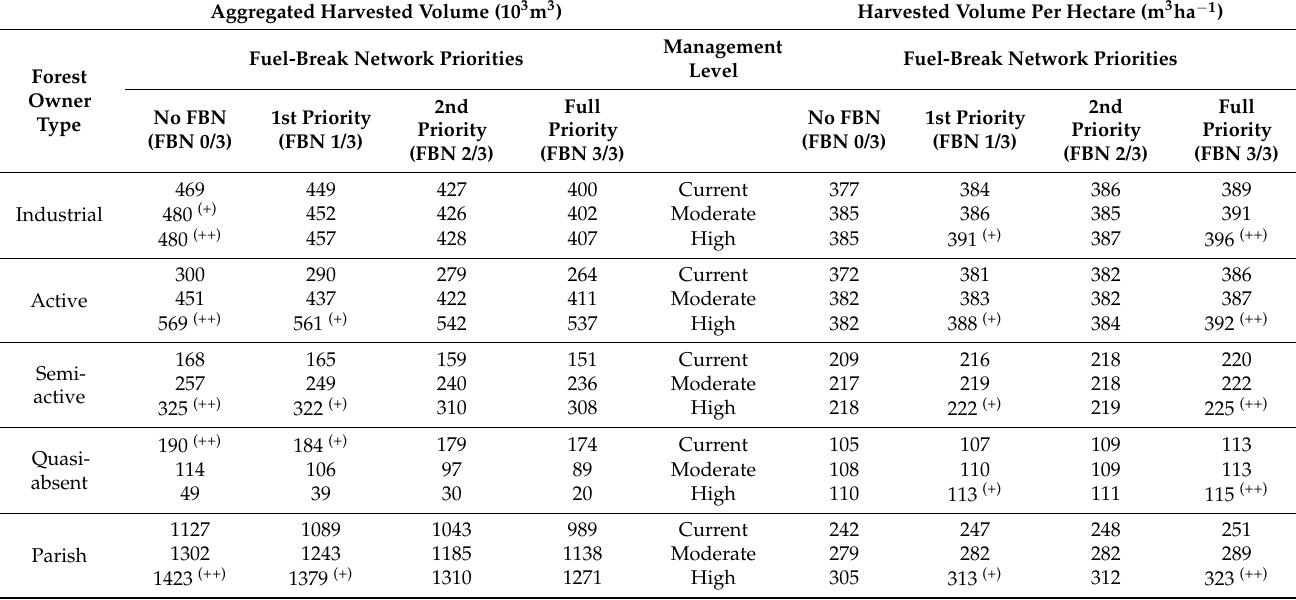
Table A2. Aggregated and per ha harvested volume for all the fire scenarios and owner types; the best and second best scenarios by owner type/parish are marked with (++) and (+),